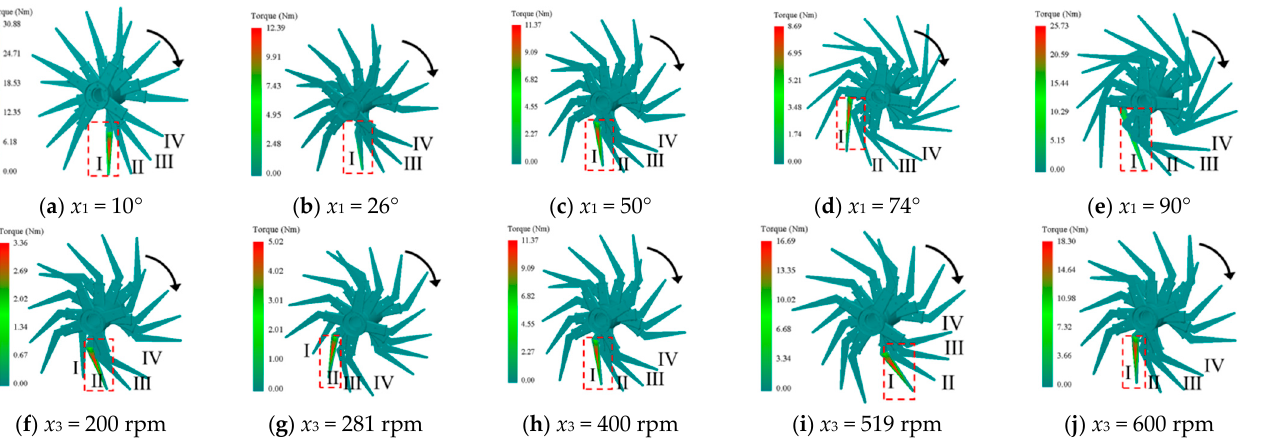
Figure 10. Torque graph of discrete element simulation test. ( a – e ) Torque e ff ect graph of di ff erent values of the edge angle of cu tt ing conditions when the rotation radius of the knife and the rotation speed of the knife roller were located at the design center point. ( f – j ) Torque e ff ect graph of di ff erent values of the rotation speed of the knife roller conditions when the edge angle of cu tt ing and the rotation radius of the knife were located at the design center point.